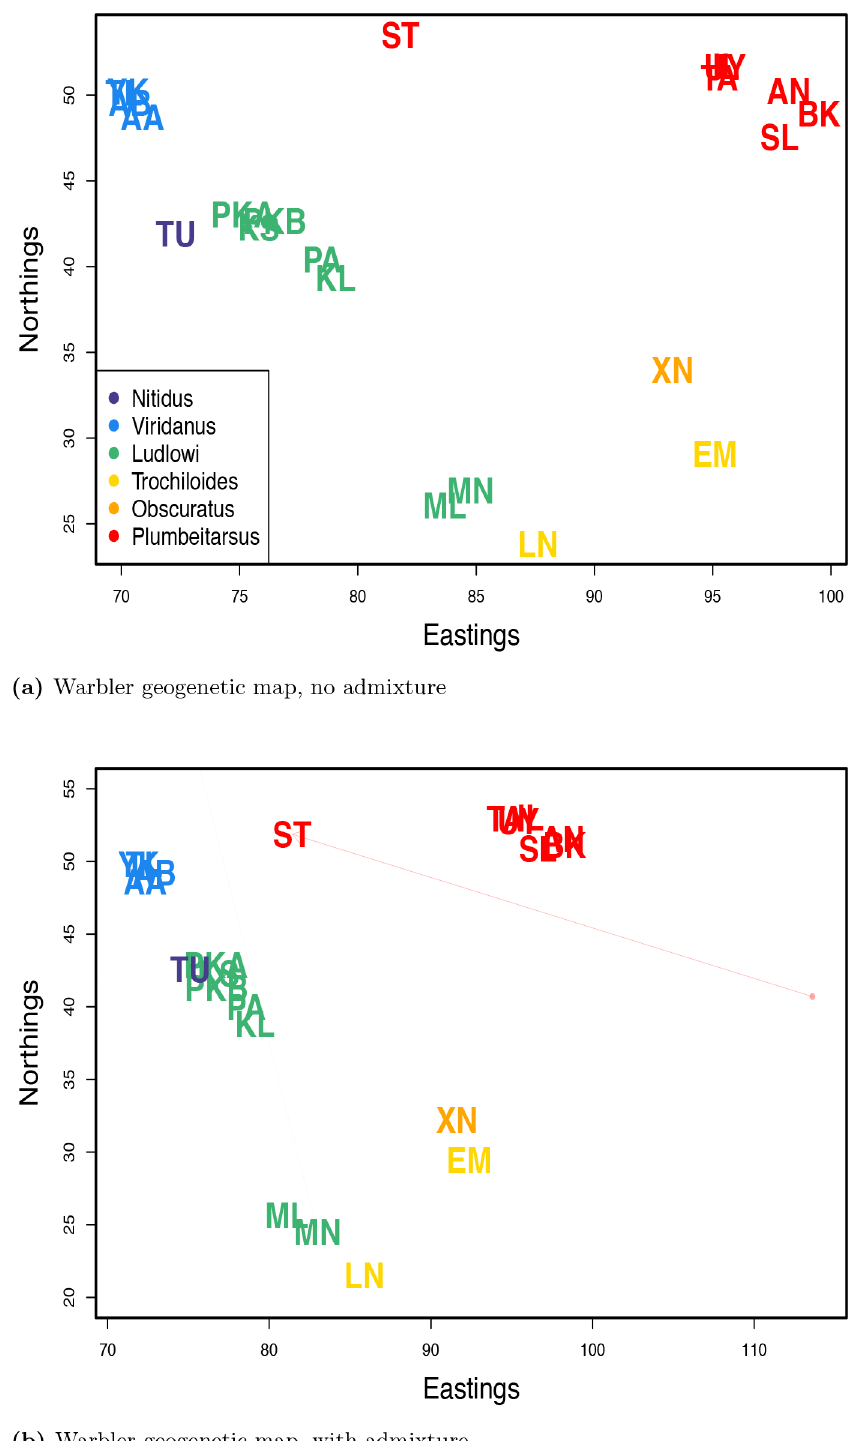
Fig 6. Inferred maps for warbler populations. Population labels are colored as in Fig 5a. a) the map inferred with no admixture inference; b) the map inferred with admixture inference.